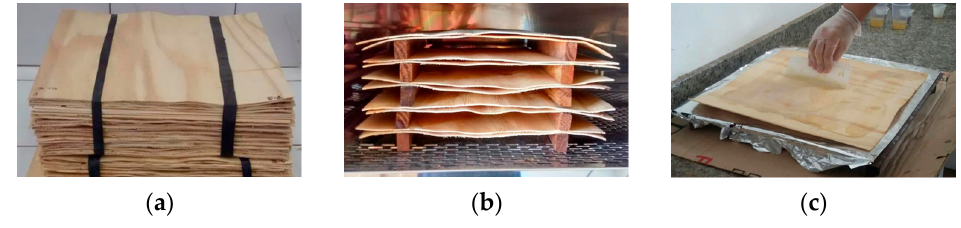
Figure 2. Veneers: ( a ) tying, ( b ) drying, and ( c ) gluing processes.